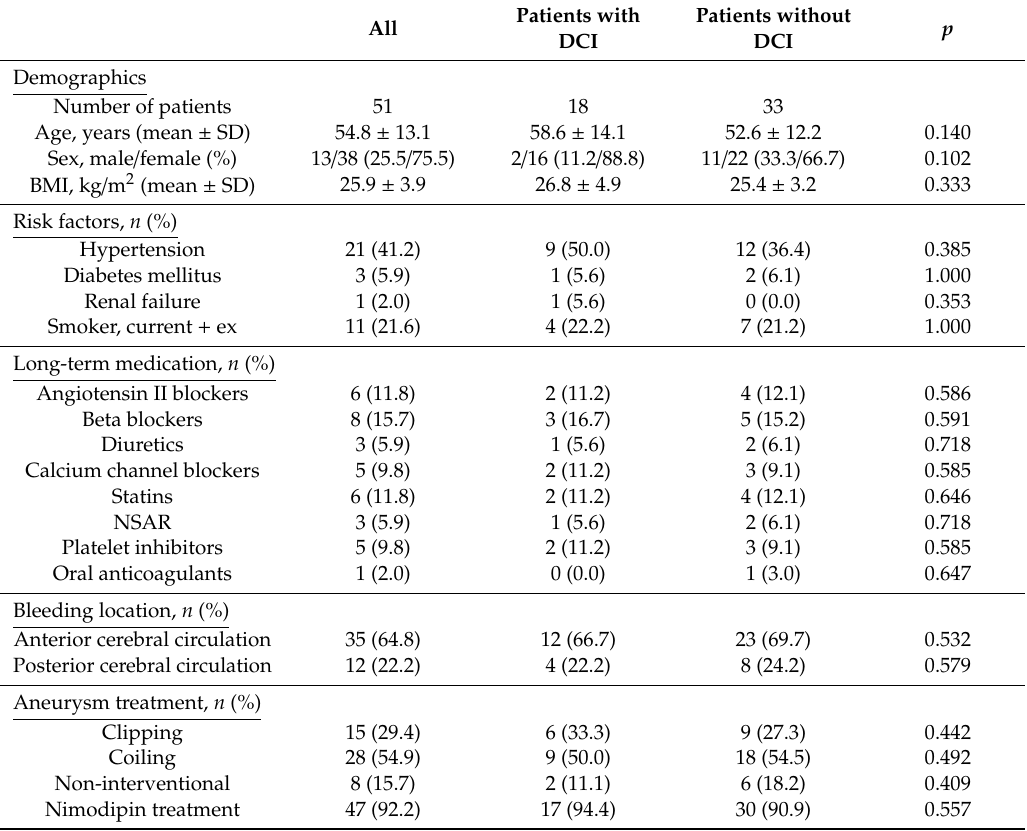
Table 1. Baseline characteristics of the patients. Patients with Patients without All DCI DCI